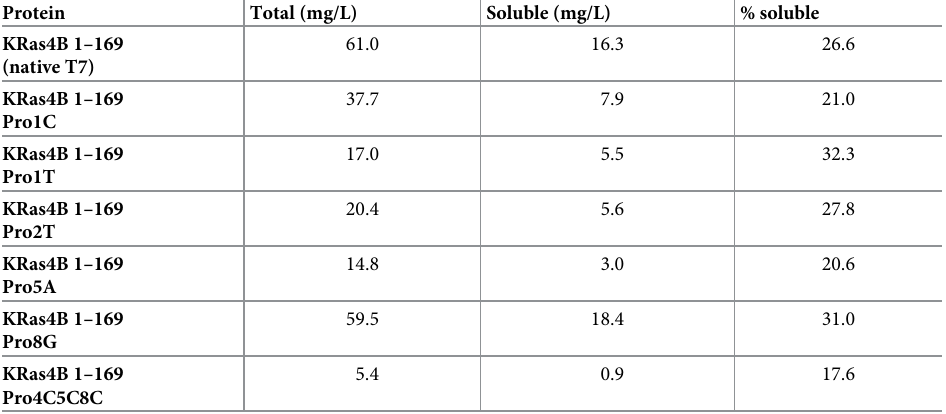
Table 2. Milligram per litre yields and soluble partitioning from KRas expressions from different T7 promoter variants.